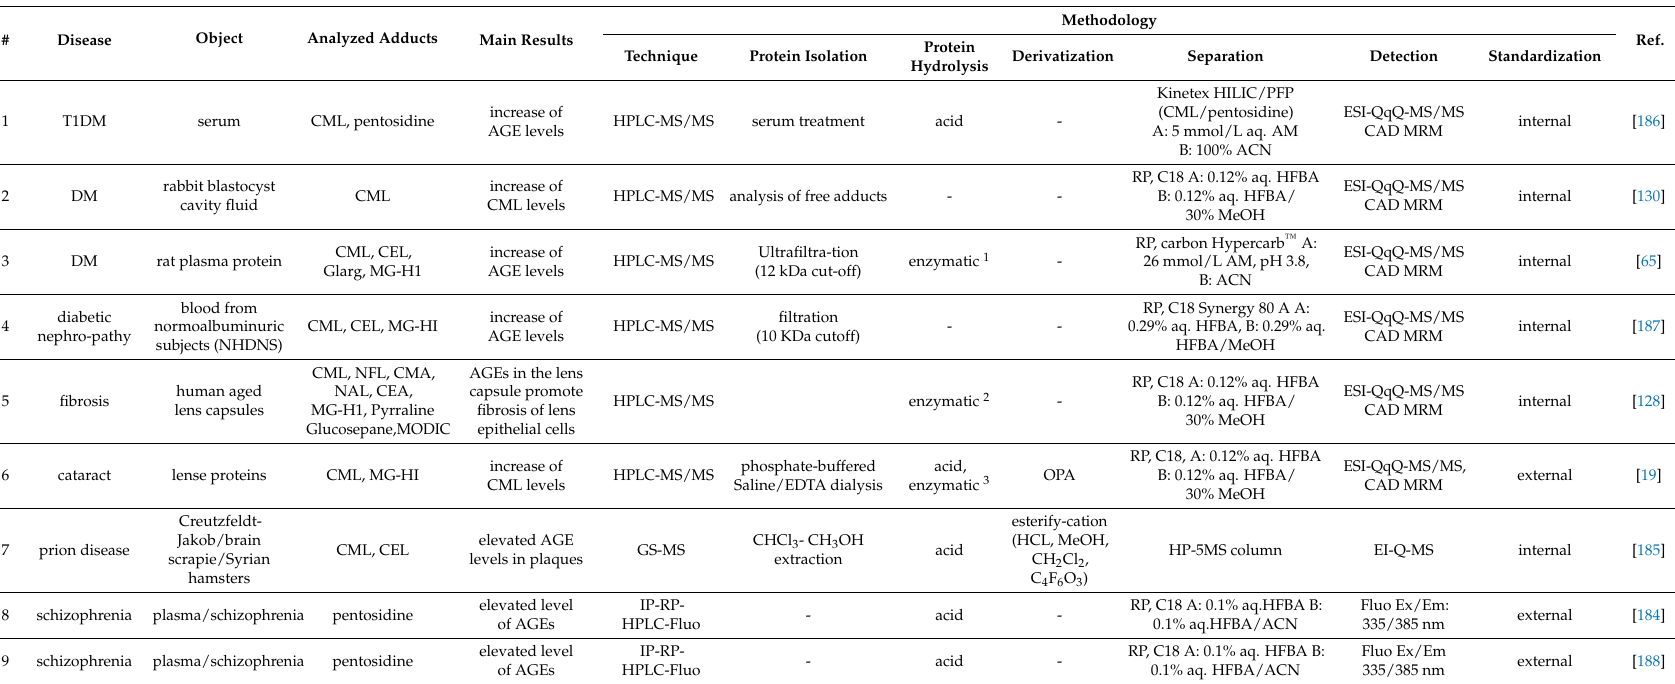
Table 2. Application of glycation adduct analysis in medical